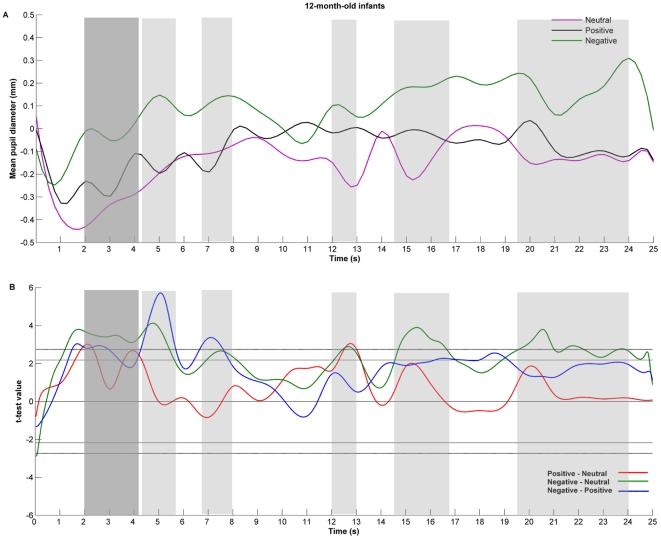
Twelve-month-old infants' pupil size changes in response to others' affective displays.In Panel A, functional expression of changes in the 12-month-olds baseline corrected pupil size in response to others' neutral (purple line), positive (black line), and negative (green line) emotional displays. Panel B shows the value of t statistic as a function of time for each pair of stimuli comparison: positive vs. neutral (red line), negative vs. neutral (green line), and negative vs. positive (blue line). The one-tailed critical values of t are represented by the vertical lines with (dotted) and without (solid) Bonferroni correction for three comparisons. The difference is considered to be significant when this line is reached or surpassed. Marked with dark gray are those time windows in which both emotional conditions triggered larger pupil diameters than the neutral one, and the hypothesized negativity bias occurred. Marked with light gray are those time windows where negative emotions triggered larger pupil diameter compared to the emotionally neutral state. (Note that the shaded areas are for illustrative purposes only, marking the time window in which the effect occurred and not the effect duration.)